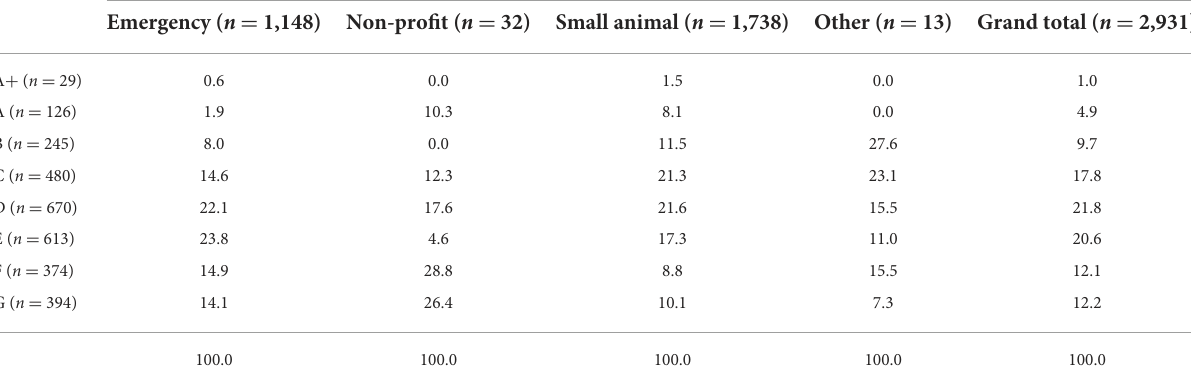
TABLE 2 Accounts with Credit Score Recommendations (CSR) by organization type. Percentage of total accounts (with CSR scores) by org type